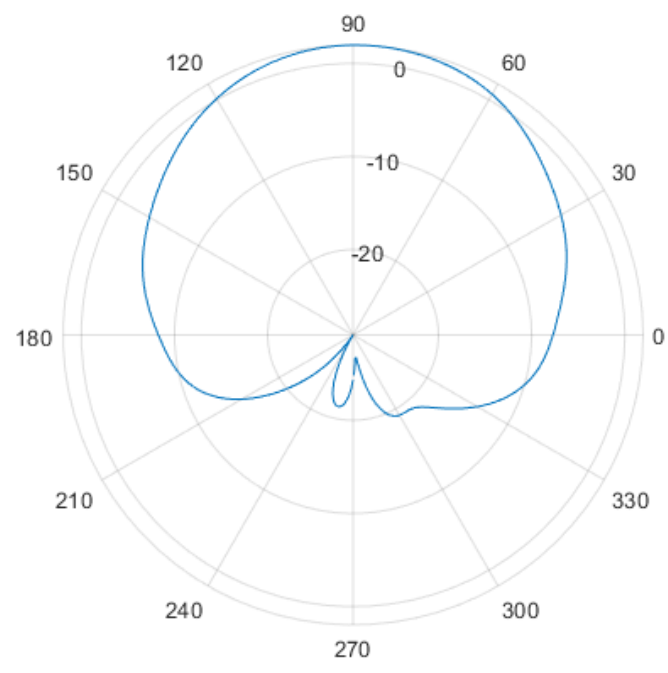
Figure 3. Measured gain pattern of the proposed antenna design at